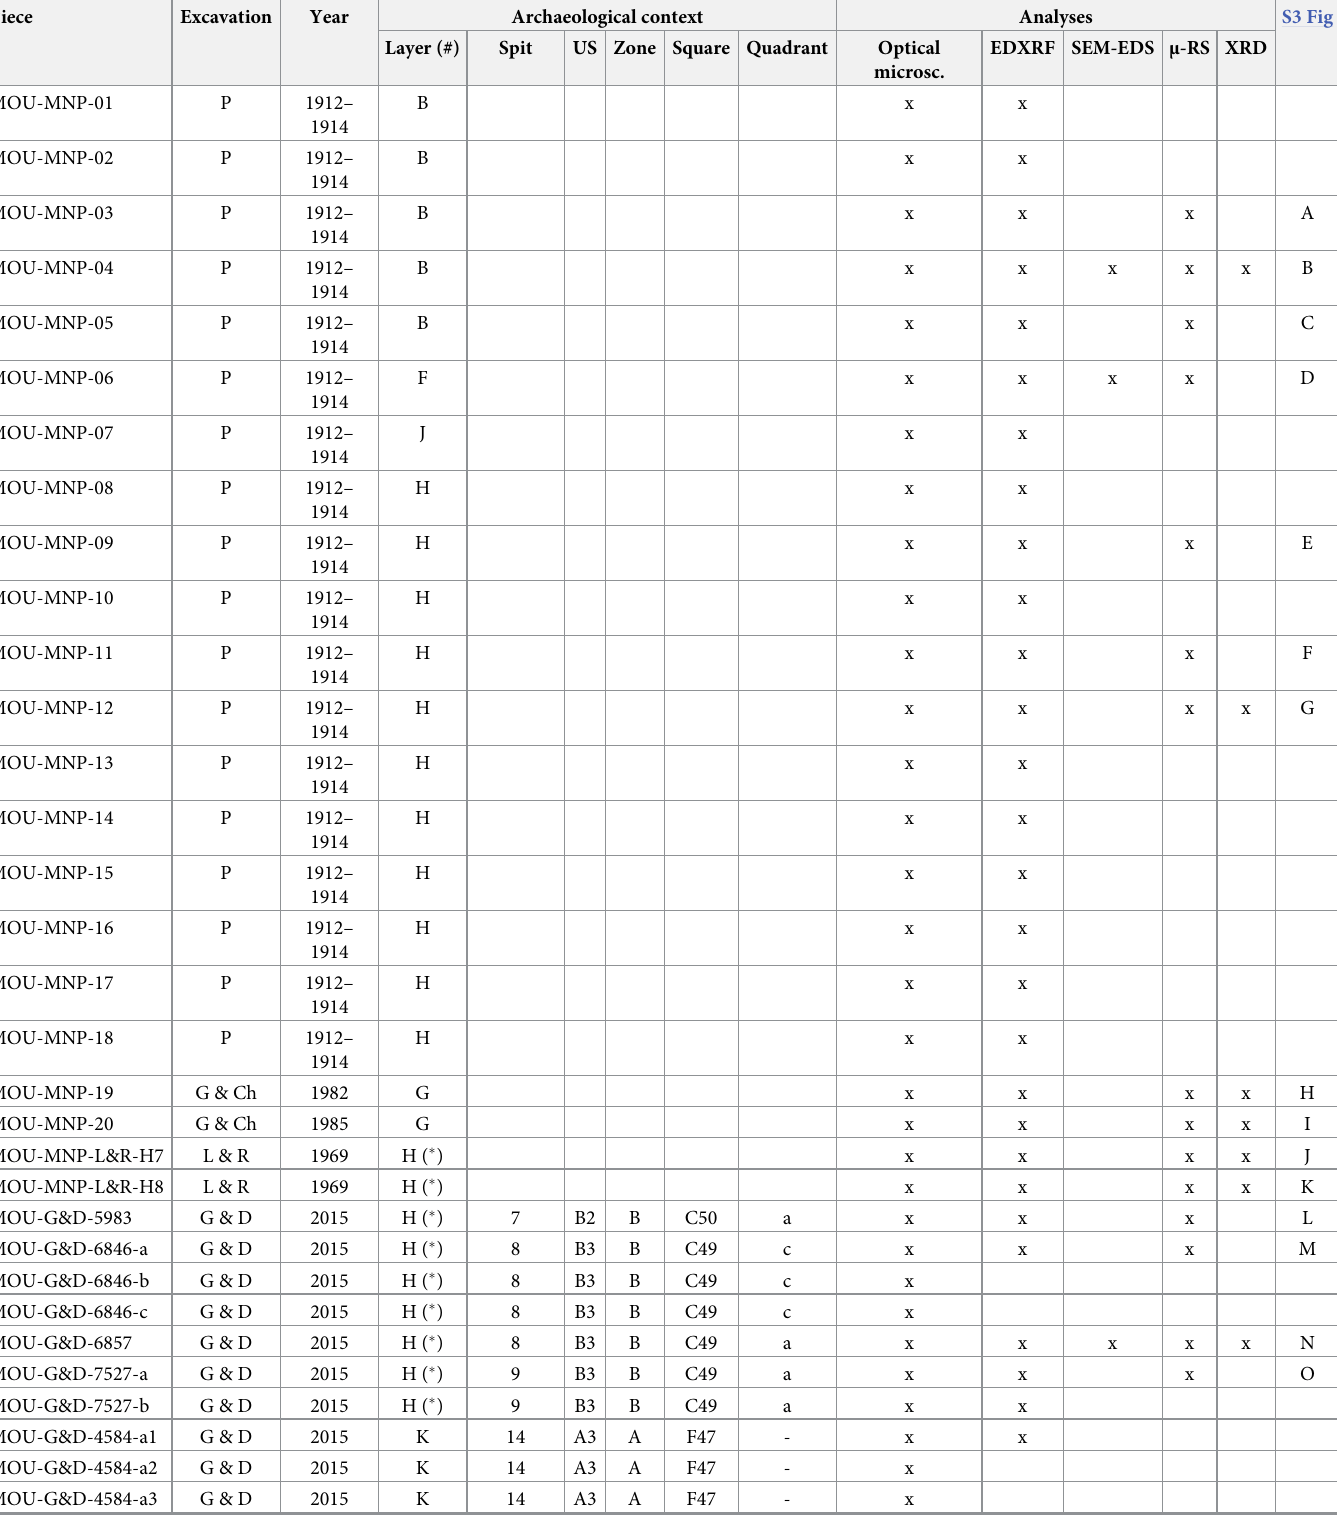
Table 1. Contextual information and analyses conducted on the Mn-rich black lumps from Le